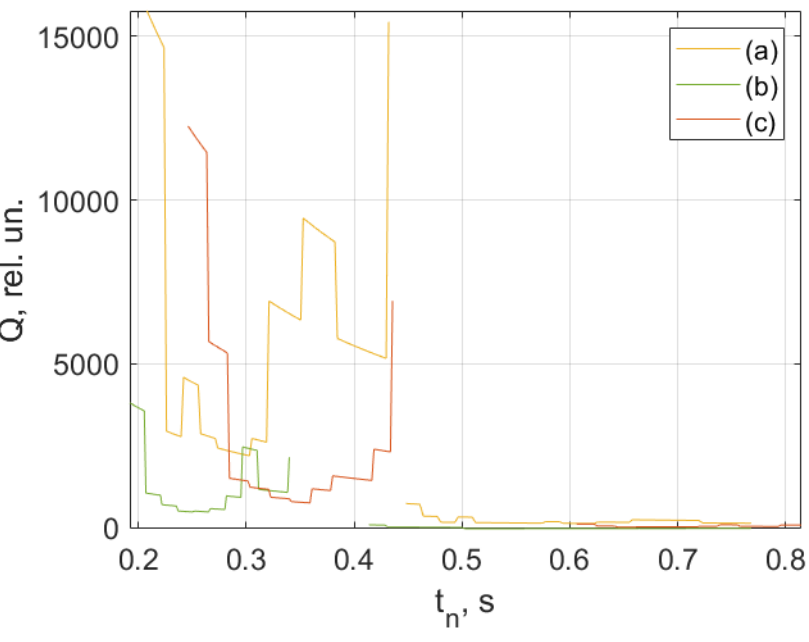
Figure 11. Results of processing the decline front of the pulse wave. The first patient ( a ) is a 25-year-old man, ( b ) is a 28-year-old man, ( c ) is a 30-year-old man. An analysis of the results obtained using a pulse wave shows that patient (a) has an unsatisfactory state of the cardiovascular system at the time of measurements, and measures must be taken. According to the research data, the cardiovascular system states of patients (b) and (c) are better. However, it is difficult to draw a definite conclusion. Additional information, in this case, is important. It is contained in data from 18 optical channels developed by the electron-optical system. The measurements were carried out at rest, during a stress test, and at the stage of restoration of blood flow. Additionally, the dynamics of changes in heart rate and SpO 2 were analyzed. The obtained dependencies for the same three patients are shown in Figures 12–14.